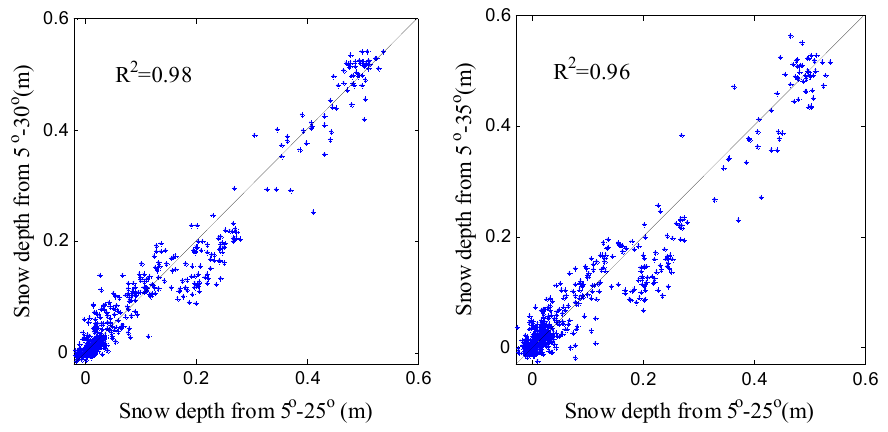
Figure 14. Comparison of snow depth estimations from different ranges of 5°–25°, 5°–30°and 5°–35° elevation angles at AB39.